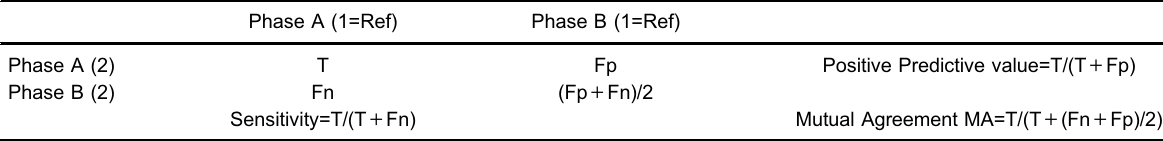
Table 1. Truth table for events